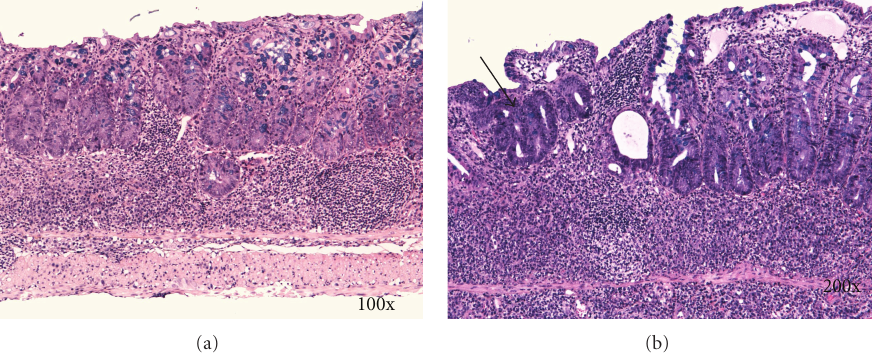
Figure 5: (a) Mononuclear leucocytes infiltration, crypt architectural disarray, and deep mucosal lymphocytosis. (b) Focally there is a moderate epithelial regeneratory atypia simulating dysplasia (arrow). Kreyberg trichrom stain (acid mucopolysaccharides are stained blue). C57BL/6JOlaHsd male mice are exposed to 3% DSS solution for 5 days followed by drinking water for 28